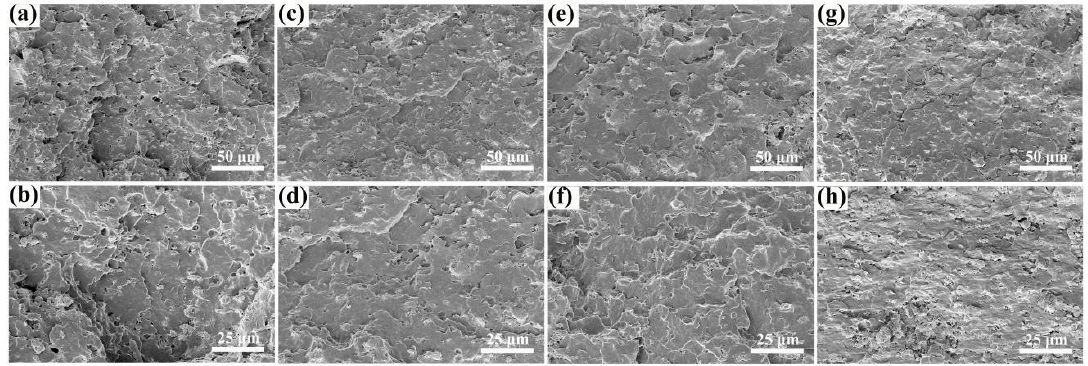
Figure 3. The fractured surface FESEM images of TH-IFR/PP ( a , b ), TH-IFR/4A/PP1 ( c , d ), TH- IFR/4A/PP2 ( e , f ) and TH-IFR/4A/PP4 ( g , h )